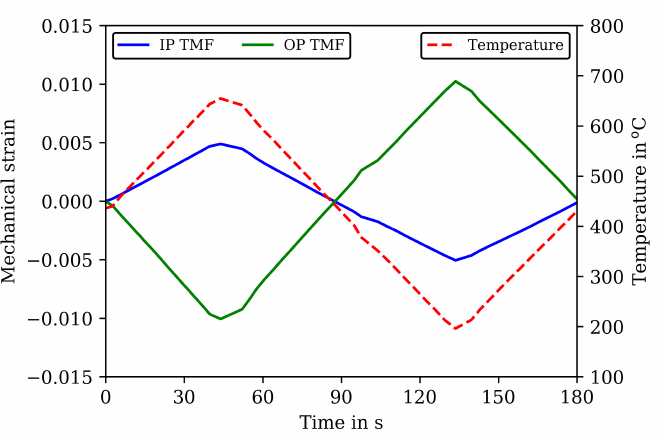
Figure 6. Mechanical strain and temperature versus time in in-phase (IP) and out-of-phase (OP) TMF